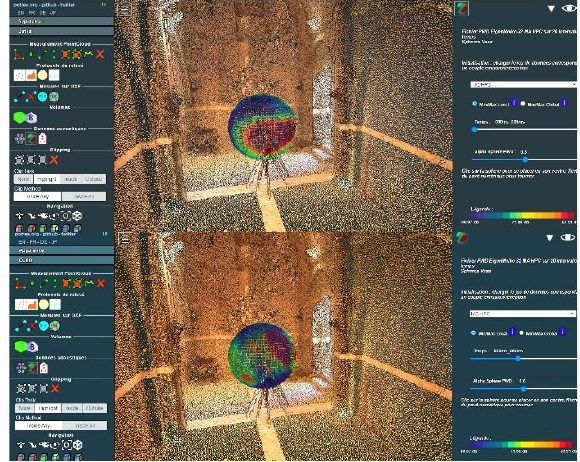
Figure 10 : Visualisation of the PWD indicator for a sound emitted on the axis of a chapel, and corresponding to two time frames (top, 0 to 0,005 milliseconds, bottom, 0,05 to 0,06 milliseconds). Note the evolution of the pattern over time, and the dissymmetry pattern (high values in dark red). In that specific case they could ascribable to an uneven distribution of